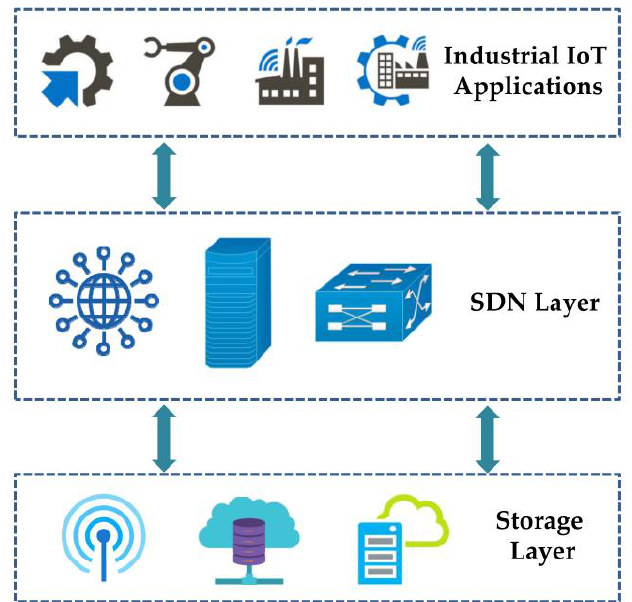
Figure 2. A basic structure of SDN integrated IoT devices.